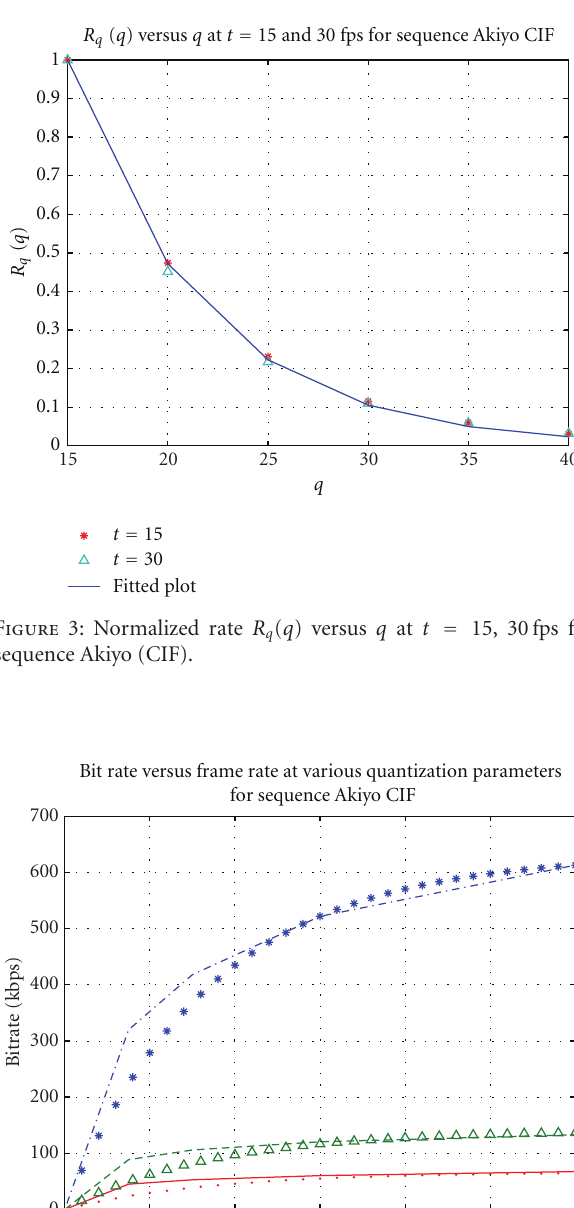
The constant Q max is the quality when the video is coded at t max , q min and can be normalized as Q max (cid:2) 100. For a fixed frame rate t f fps, the quality depends exclusively on the quantization parameter given by Q q ( q ). This function can then be employed as a handle to maximize the video